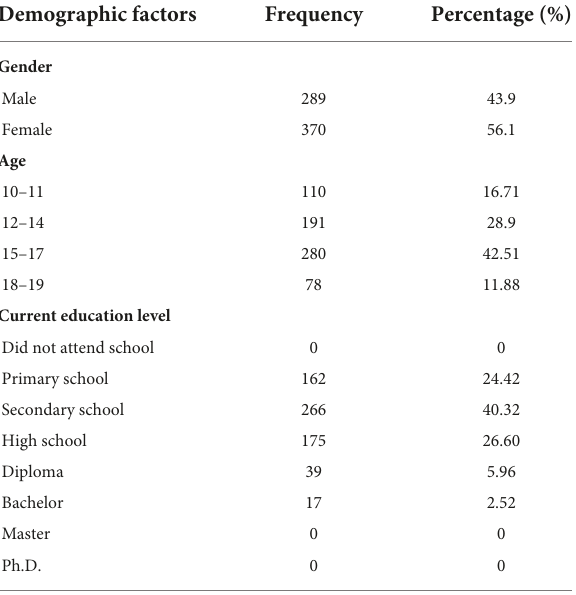
TABLE 2 Comparison of R 2 value between baseline model and marker included the model. Relationships Without With marker marker variable